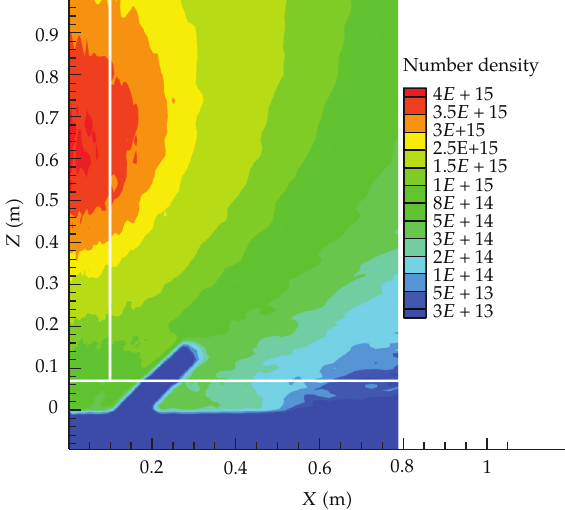
Figure 6: Contours of number density for slice through surface